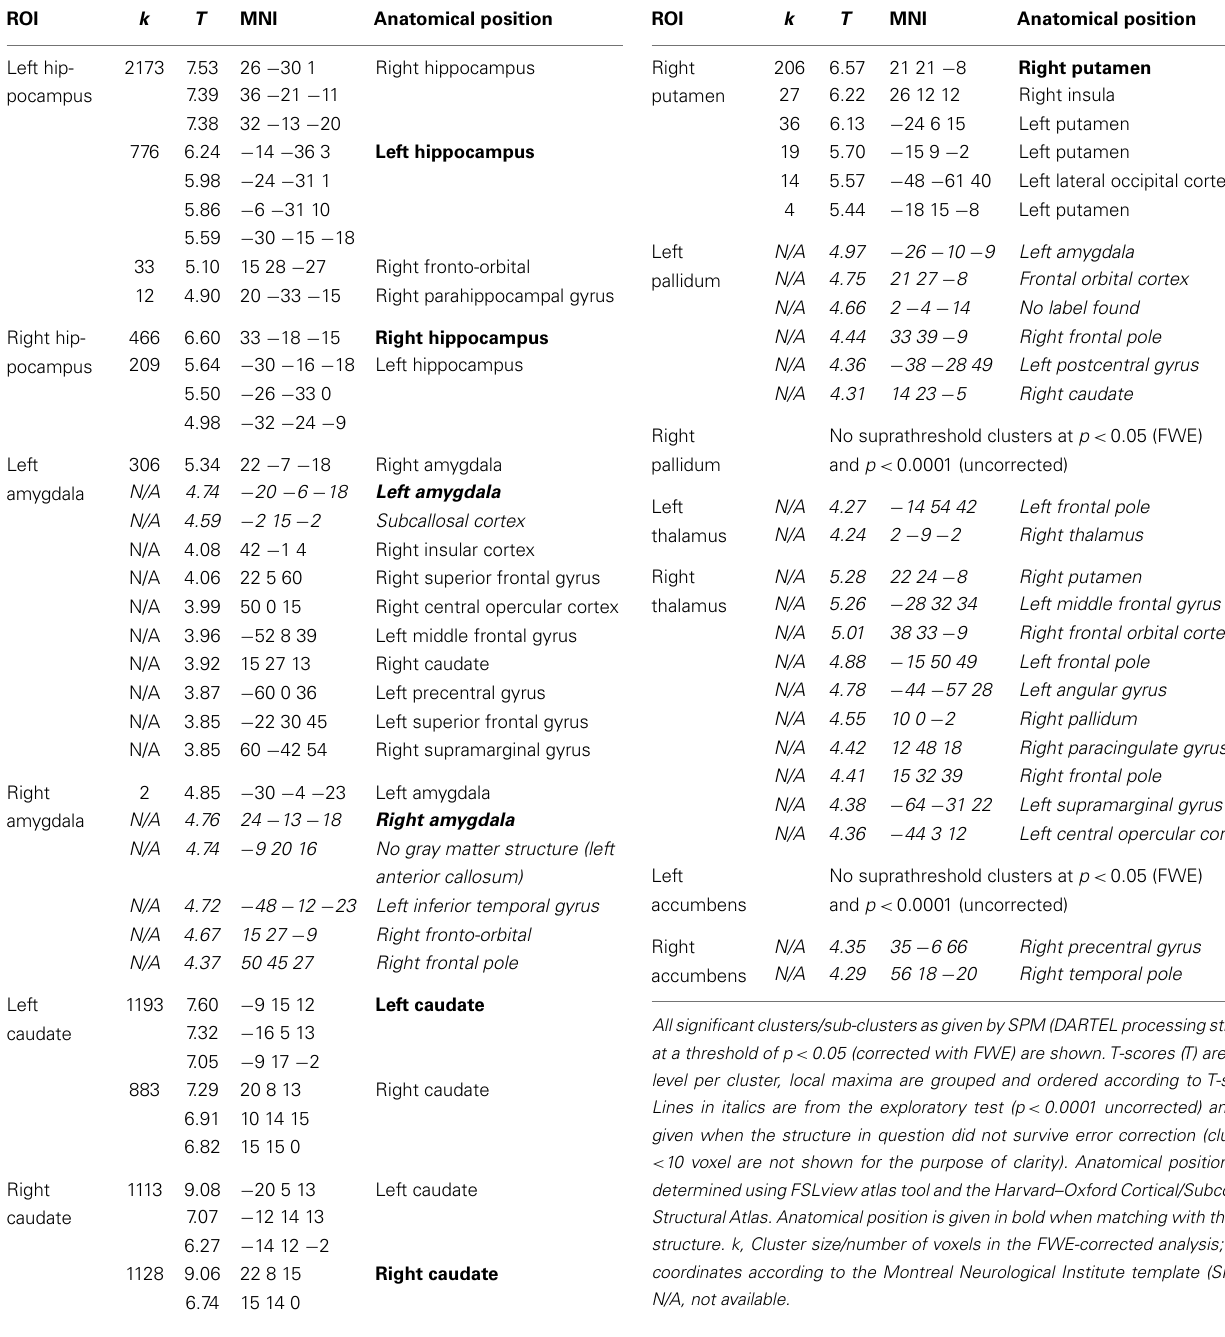
Table 3 | SPM results (DARTEL)